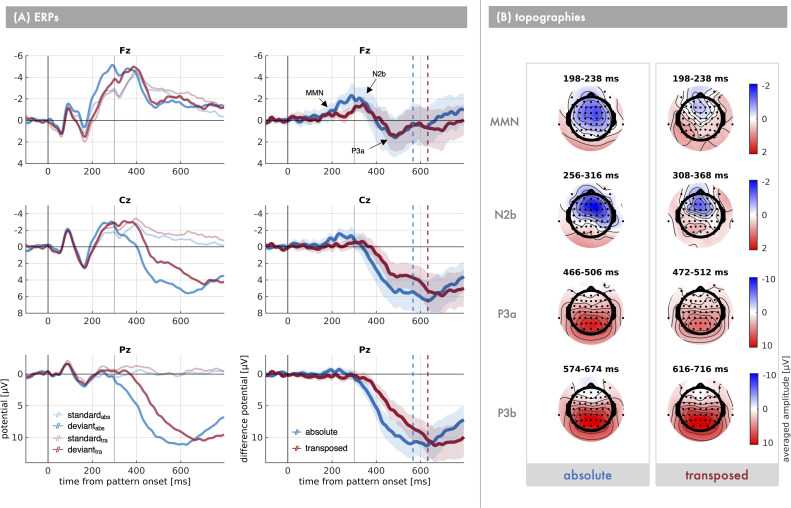
Grand averaged ERP waves.(A) Grand-averaged nose-referenced ERP waves of n = 17 participants at midline electrodes Fz (top), FCz (middle) and Pz (bottom) as a function of condition (blue: absolute, red: transposed) and stimulus (left: standard and deviant response, right: deviant–standard difference). The shaded area represents ± 1 SEM around the difference potential. The ERP components are labelled where appropriate. The solid grey vertical line marks the pattern offset, while the dashed vertical lines denote the average response time in each condition. Please note, that the point of deviation occurs at 50 ms, that is with the start of the second segment of a pattern. (B) Topographies depict the window-averaged deviant–standard difference amplitude around each ERP component‘s peak for both conditions (left: absolute, right: transposed) respectively.